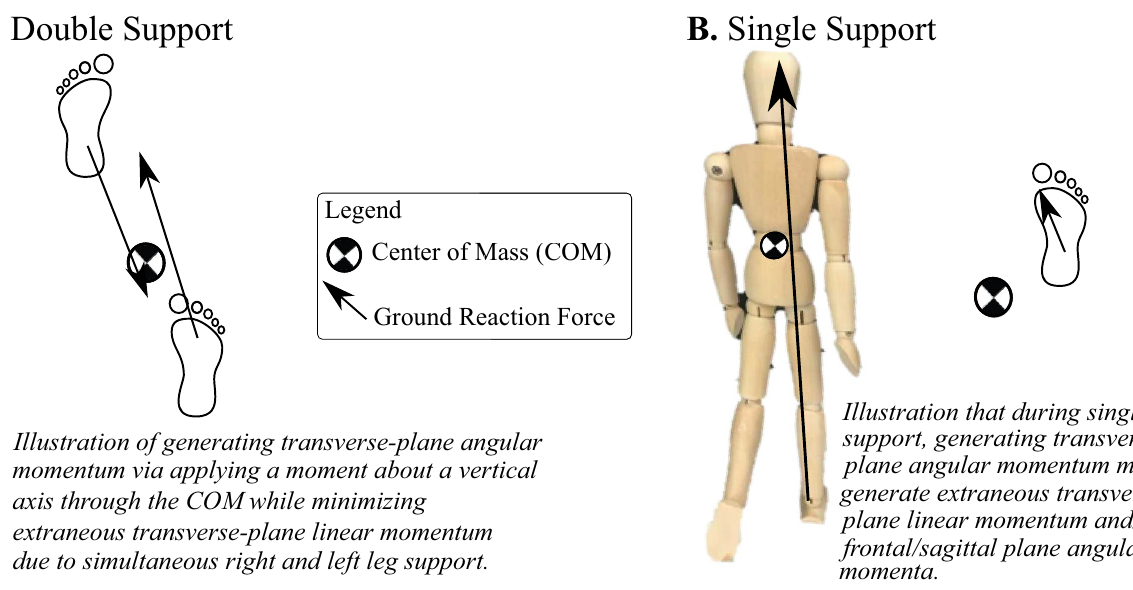
Figure 1. Illustration to explain the mechanical context to generate transverse-plane angular momentum during ( a ) double support, when both feet contact the ground vs. ( b ) single support, when only one foot is in contact with the ground . During double support, two legs can work together to avoid extraneous linear impulse generated by each of their ground reaction forces. In contrast, during single support, the linear momentum generated by the ground reaction force from the leg in contact with the ground cannot be concurrently neutralized by the other leg (because the other leg is not in contact with the ground), which can lead to extraneous linear momentum